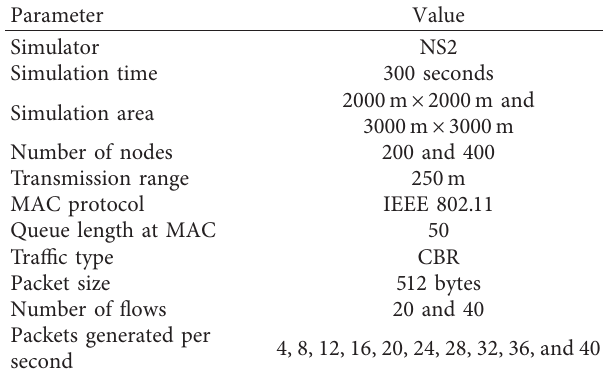
Figure 6: Packet delivery ratio.